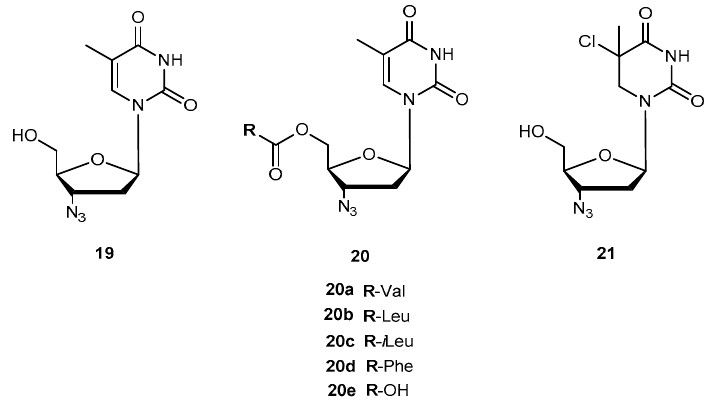
Figure 9. Chemical structures of 19 and its amino acid ester prodrug. Cytotoxicity and inhibition assays were performed in two different cell types: peripheral blood mononuclear cells (PBMCs) and MT2. During evaluation of cell viability, the compounds also showed a dose-dependent cytotoxicity. Although parameters obtained when using different methodologies cannot be directly compared, their correlation was significant. In one or both cell cultures used, all the prodrugs synthesized have a similar or higher selectivity index than 19 itself, with the exception of 20f which showed no anti-HIV activity and 20d that showed a diminished capacity to inhibit HIV replication. These facts could be directly related to the high acidity of their amino acids or higher volume. However, neither acidity level nor volume explains the activity variation showed by the rest of the compounds. Authors hypothesized that it could be due to different transport mechanisms depending either on the amino acids involved (for special transport) or lipophilicity of the substituent that might be implicated in each case. 20a and 20c demonstrated an improved ability to inhibit HIV replication on both cell types studied. Nonetheless, using amino acids to design 19 derivatives result in increased activity of parent drug [58]. Santos et al. also designed new analogues of 19 using 5 (cid:48) - O -ester substitution, however, instead of single amino acid, they used dipeptides ( 22a – h , Figure 10) to target the human intestinal oligopeptide transporter hPEPT1 and evaluated their stability at pH 7.4 in buffer and human plasma, cytotoxicity and retroviral activity